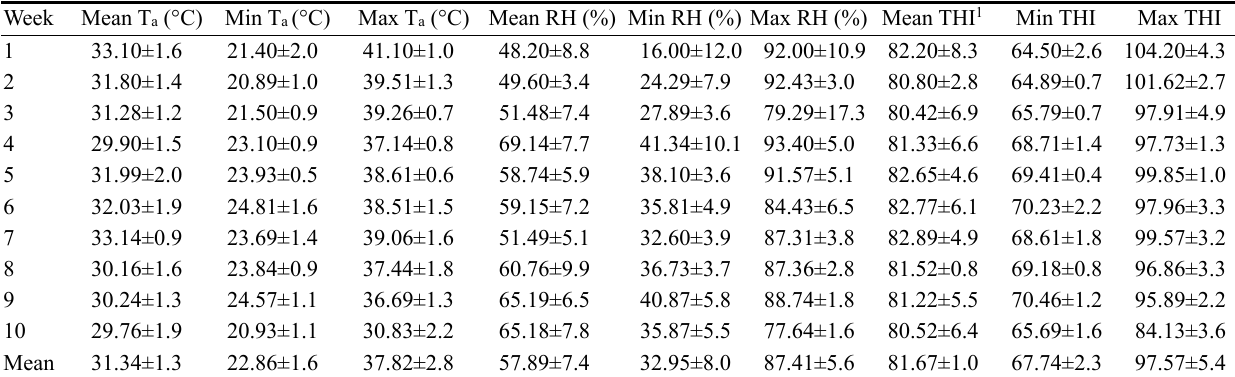
Table 2. Ambient temperature (Ta), relative humidity (RH) and calculated temperature-humidity index (THI) registered every hour and expressed as a weekly average)